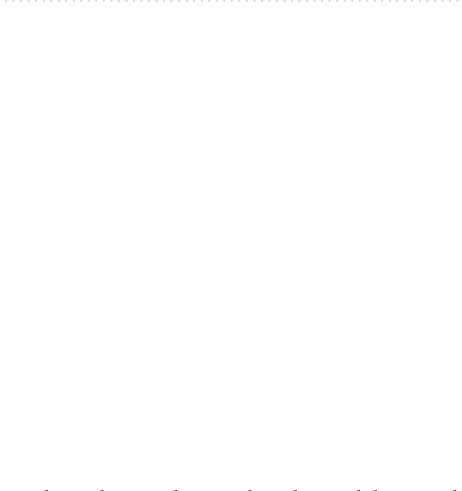
Table 2. Quality score of binarized images. The two independent graders attributed to each binarized image a score ranging from 0 (< 20% of overlapping), 1 (< 80% of overlapping) and 2 (> 80% of overlapping).